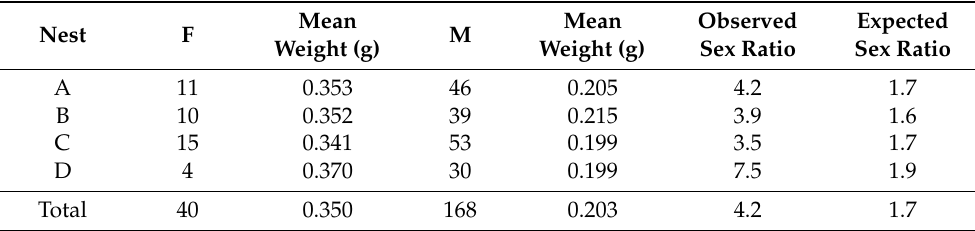
Table A1. Progeny weight differences and sex ratios in adult M. sculpturalis